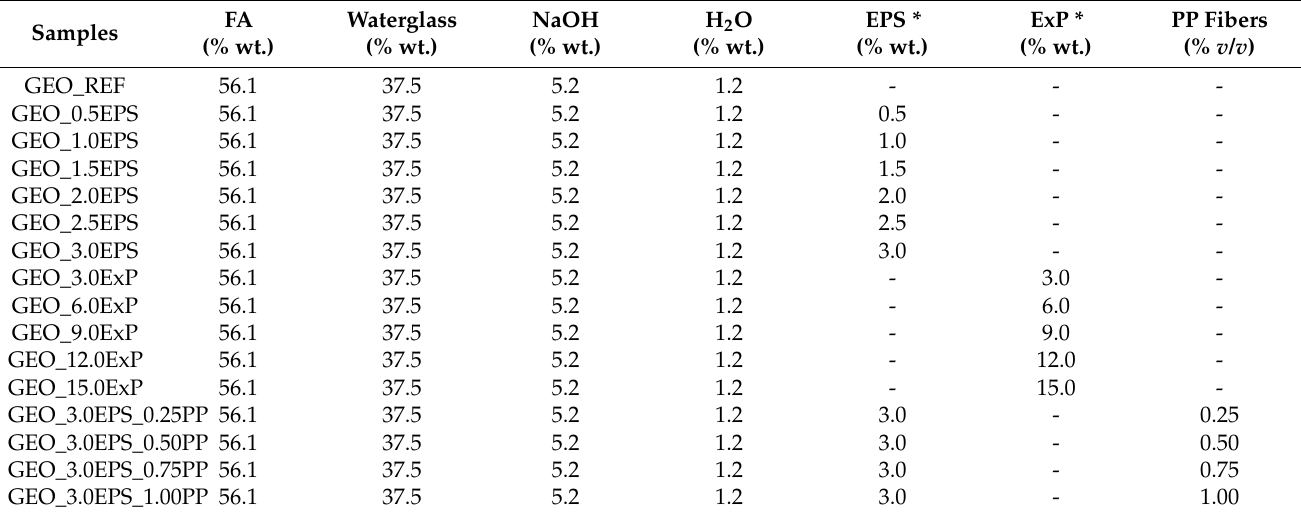
Table 3. Geopolymeric samples prepared in this study.